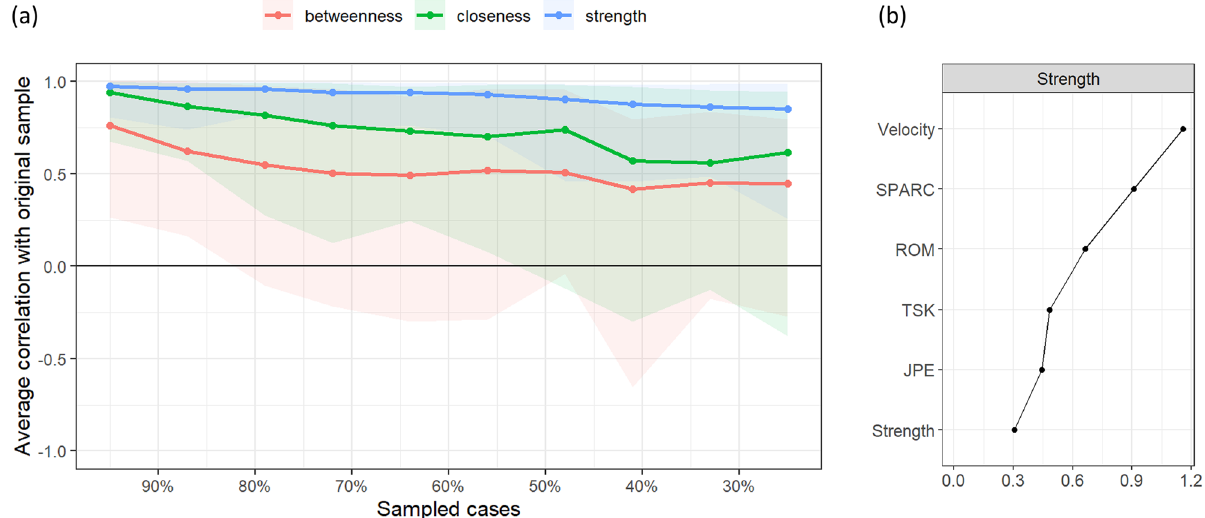
Figure 3. Correlation stability plot of centrality indices obtained from case-dropping bootstrap ( a ) and node centrality measure of Strength (raw coefficients). ( b ) Betweenness and closeness were not stable since their large confidence intervals and the poor correlation with original values when 50% of cases were dropped. JPE Joint position error, ROM Range of motion, TSK Tampa scale for kinesiophobia (fear of